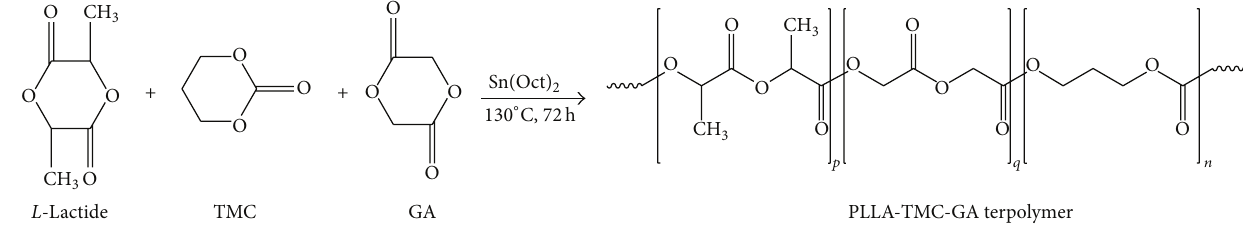
Figure 1: Synthesis route of PTLGA terpolymers. By permission from Shen et al.